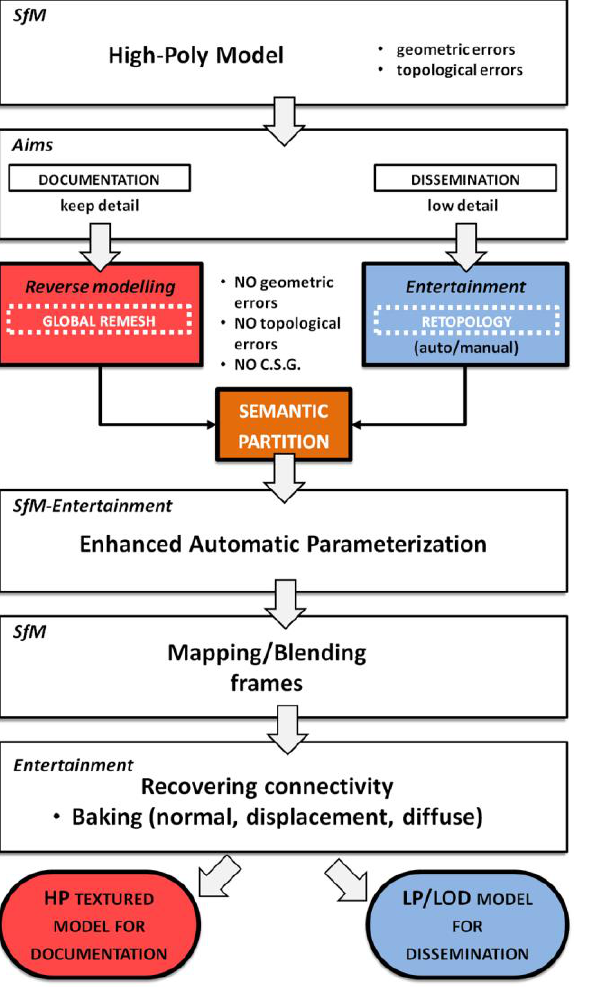
Table 3. Workflow for parameterization enhancement.